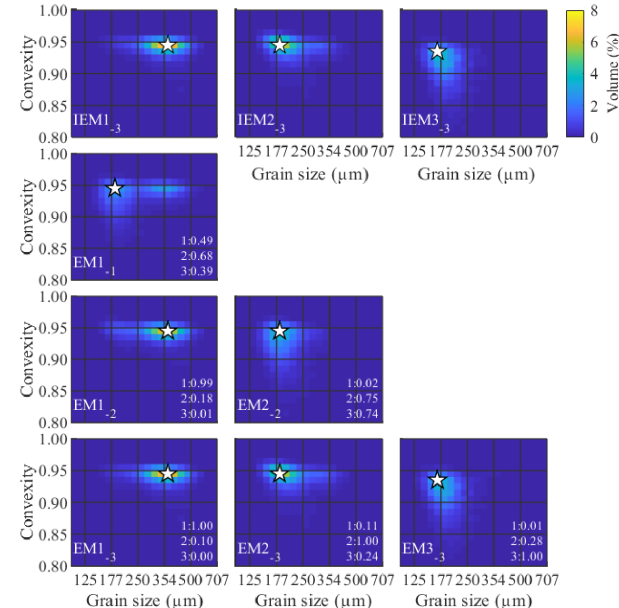
Figure A3. Input and determined endmember SSDs for the 3EM_nonoise dataset.